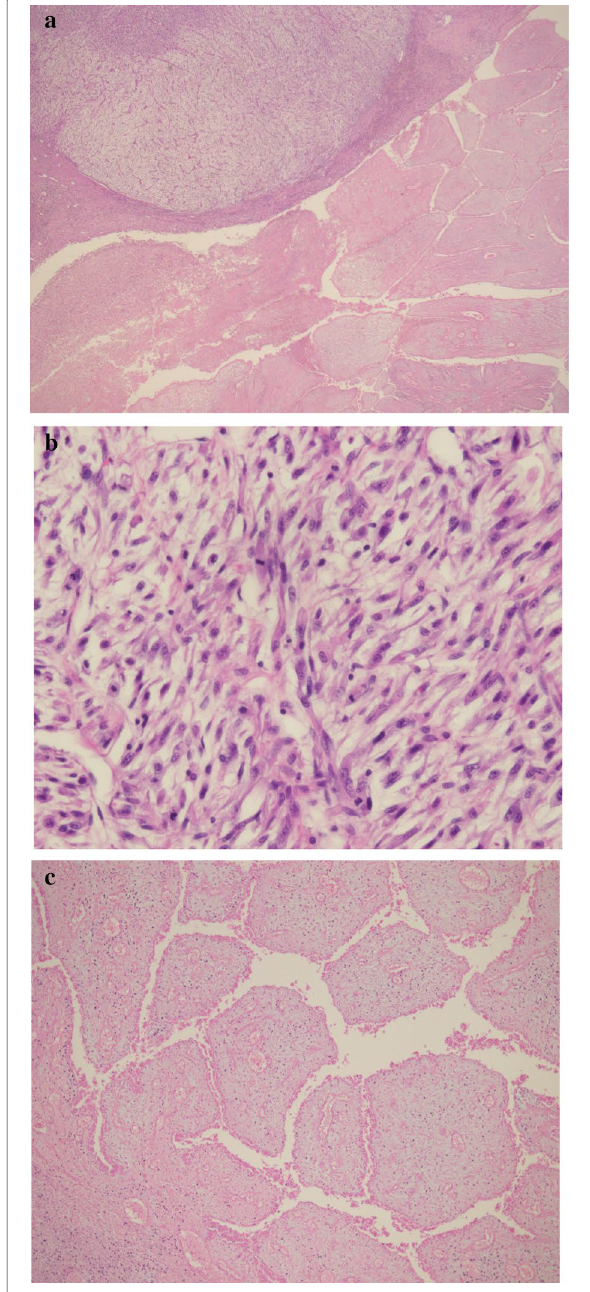
Fig. 4 The histopathological findings revealed atypical spindle-shaped cells with enlarged nuclei and exhibited a fibrosarcoma-like morphology ( a ) (HE stain, 2). Numerous mitoses × were noted ( b ) (HE stain, 40). A degenerated leaf-like structure was × found in the center of the lesion ( c ) (HE stain, ×